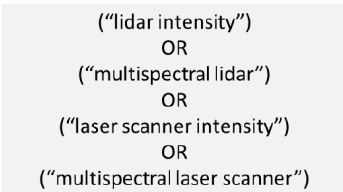
Figure 1 . The three wavelengths (represented by green, yellow and red vertical bars in the upper figure) of Optech Titan compared with spectral signature of different objects and normalized LiDAR intensity images for the three channels (at the bottom) – source: www.teledyneoptech.com.